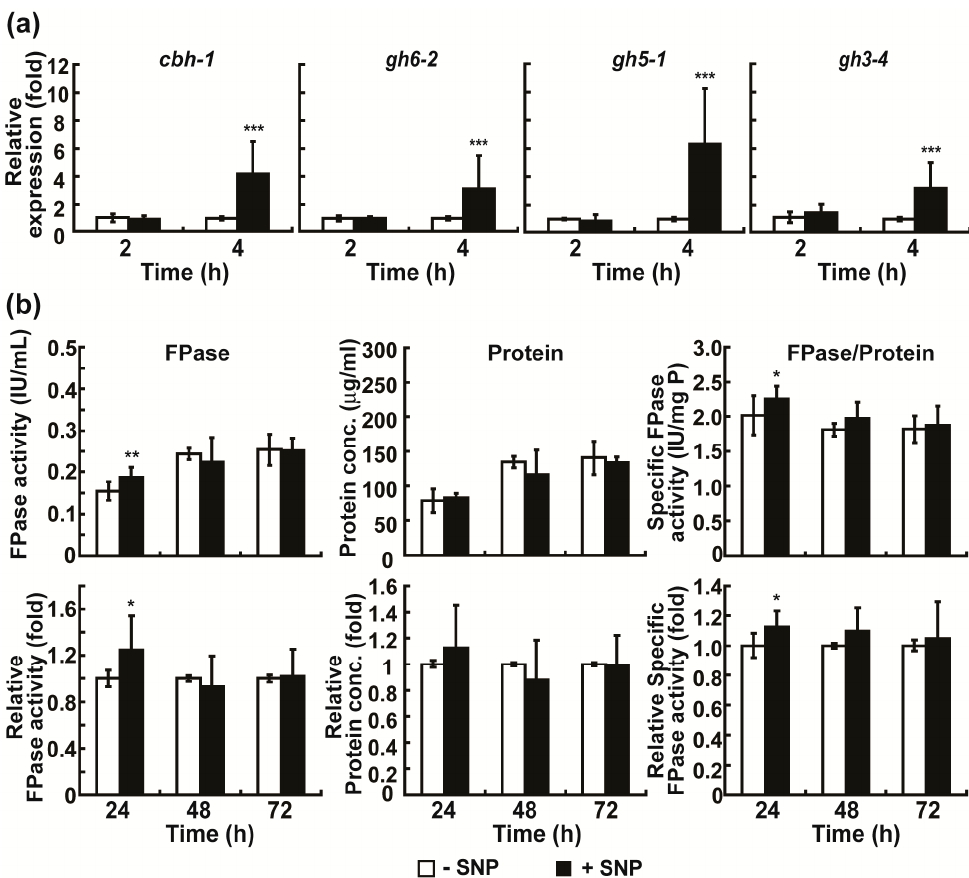
Figure 6. Effect of sodium nitroprusside (SNP) treatment on cellulolytic enzyme production. ( a ) mRNA levels of cellulolytic enzymes ( cbh1 , gh6-2 , gh5-1 , and gh3-4 ) in fungal hyphae grown in Avicel medium with or without SNP for 2 and 4 h. ( b ) FPase activity (total activity of cellulolytic enzymes), total protein concentration, and specific enzyme activity measured in media after fungus was grown in Avicel medium with or without SNP for 24, 48, and 72 h. − SNP group: only Avicel medium, +SNP group: 0.01 mM SNP in Avicel medium. Each value is the mean of nine replicate measurements (three replicates per experiment and three independent experiments): * p < 0.05, ** p < 0.01, *** p < 0.001 as determined by Student’s t -test.